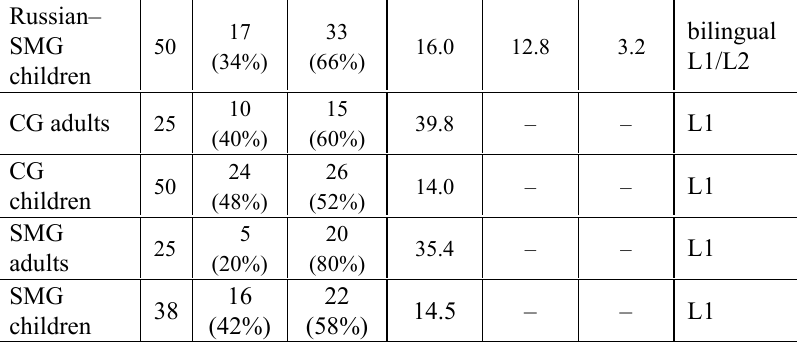
Table 2: Participants in the written task